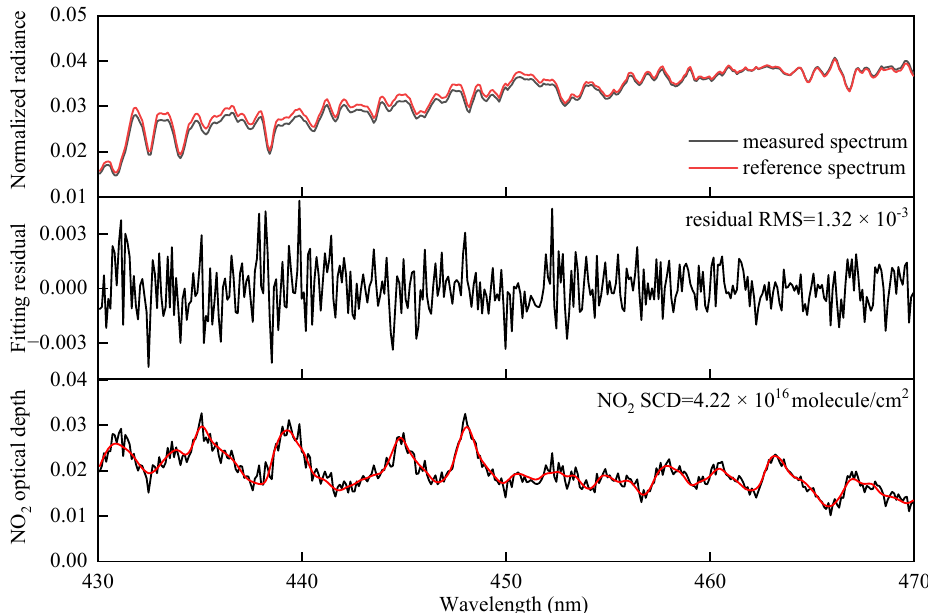
Figure 4. An example of NO 2 DOAS fitting of the measurement of the 102nd pixel of the nadir module as the NO 2 sample gas concentration is 198 ppm using scattered sunlight.